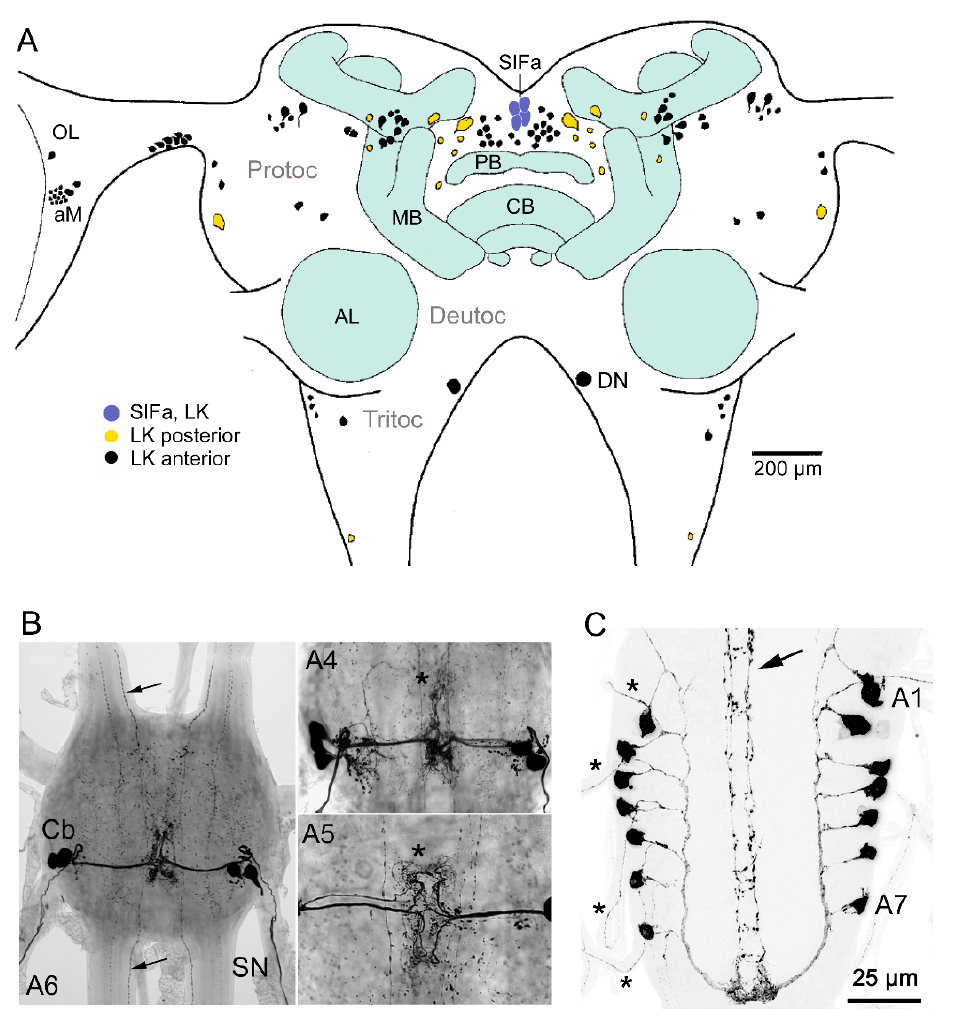
Figure 6. LK neurons in the CNS of the locust. ( A ) LK immunoreactive neurons in the brain of the locust L. migratoria . LK cell bodies are predominantly found in protocerebrum (Protoc), including the optic lobes (OL) and accessory medulla (aMe; pacemaker region of clock), but some are in tritocerebrum (Tritoc). Neuronal process from LK neurons (not shown) are in the central body, optic lobe, and antennal lobe (AL), and less delineated neuropils are shown in all three brain neuromeres. A group of four neurons (SIFamide producing (SIFa)) in the pars intercerebralis coexpress SIFamide and LK. These SIFa neurons are known to send processes throughout the brain and ventral nerve cord [83,84] similar to the four SIFa neurons in Drosophila [85]. ( B ) LK immunoreactive neurons (neurosecretory cells) in abdominal ganglia of the locust Locusta migratoria . In more anterior abdominal ganglia (A1–A4), there are three pairs of LK neurons, and in the posterior ones (such as A6 shown here), there are only two pairs. The arrows depict axons from the descending neurons (a total of four axons). Other abbreviations: Cb, cell body; SN, segmental nerve. ( C ) In larval Drosophila , there is one pair of LK immunoreactive ABLKs (abdominal ganglion LK neurons) in each of the abdominal neuromeres A1–A7. These send axons to the body-wall muscle via segmental nerves (asterisks). Arrow indicates axons of the two pairs of descending neurons, SELK. Panel A is altered from [34] with SIF neurons added [83], B is from [86], and C is altered from [87]. All figures used with permission from publishers.